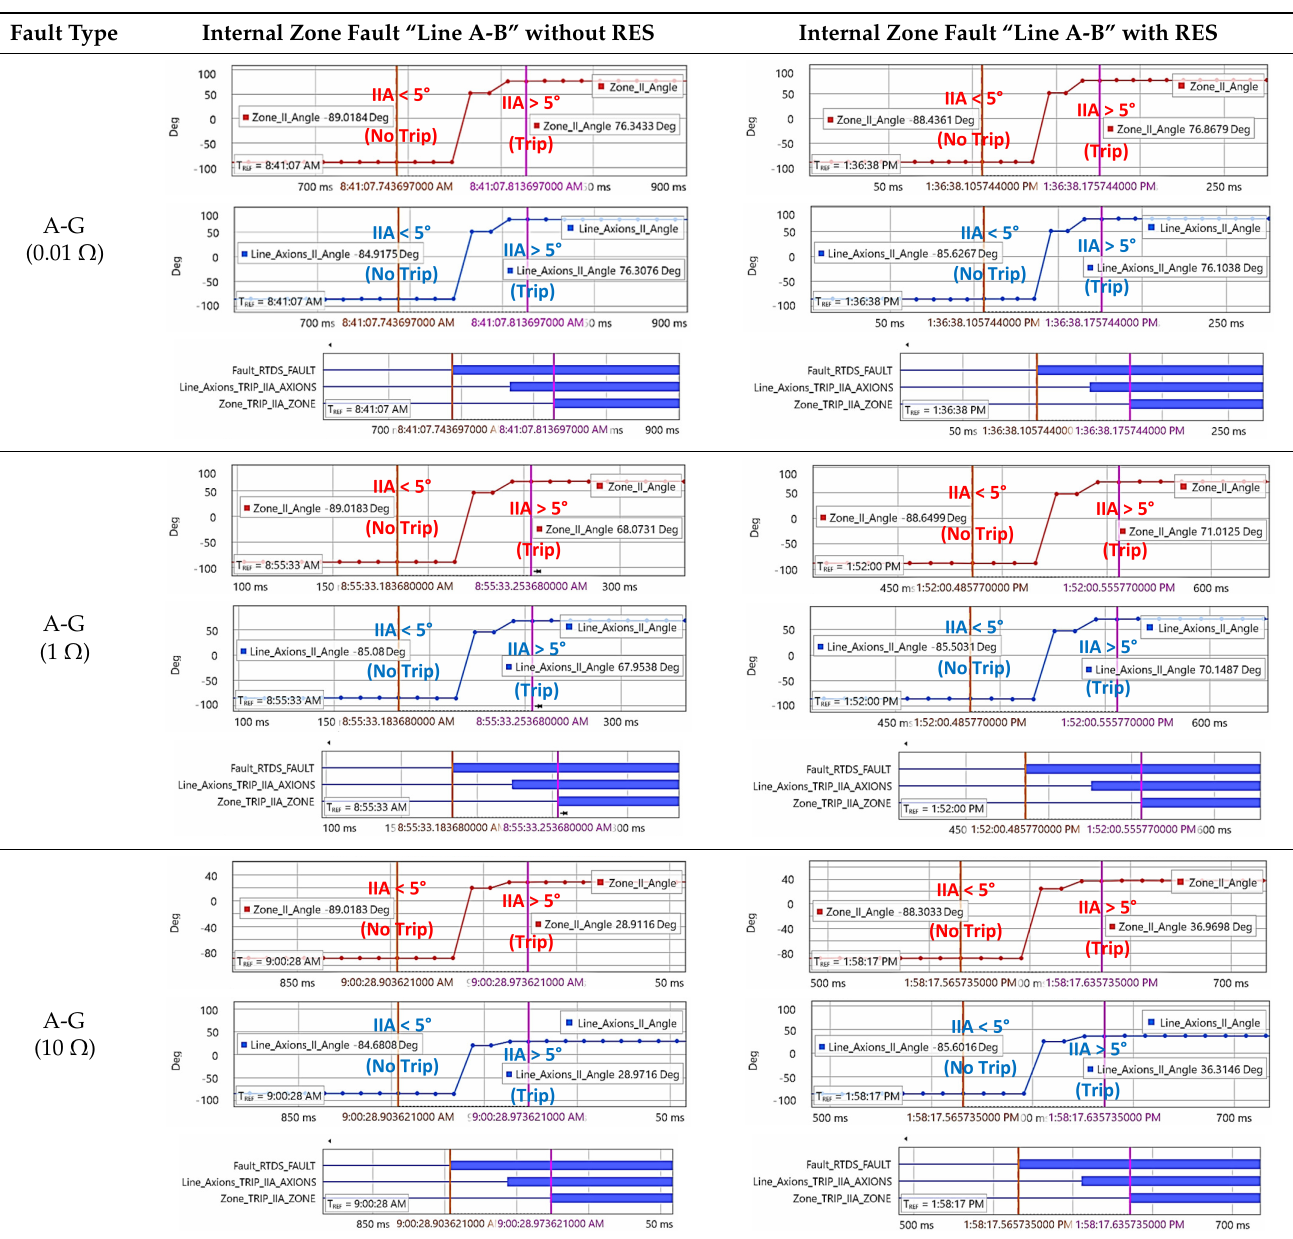
Table 10. IIA Zone behaviour, different fault resistance, with and without